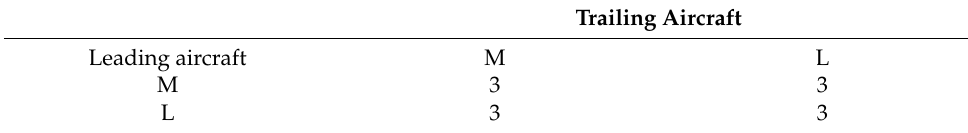
Table 1. Wake turbulence separations (nm) [42].